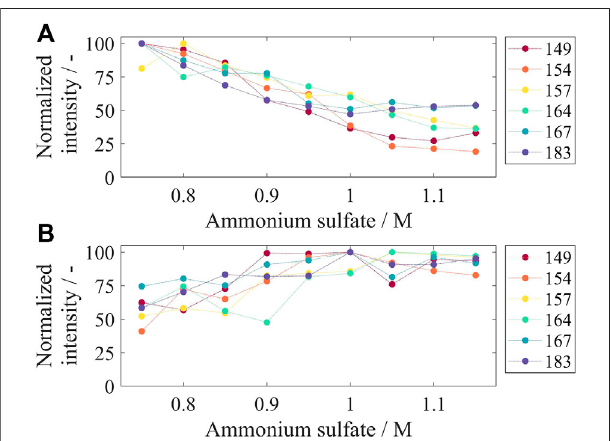
FIGURE 5 | Remaining VLP constructs in precipitation supernatant (A) and re-dissolved VLP constructs after precipitation and re-dissolution overnight for different tested ammonium sulfate concentrations. After precipitation with different ammonium sulfate concentrations, the supernatant (A) and re-dissolution solution (B) were analyzed by SDS-PAGE, and gel scans were evaluated by the intensity of the VLP band on the gel lane with respect to the highest determined intensity for the respective construct. Corresponding gel images can be found in Supplementary Material S4 ; VLP, virus-like